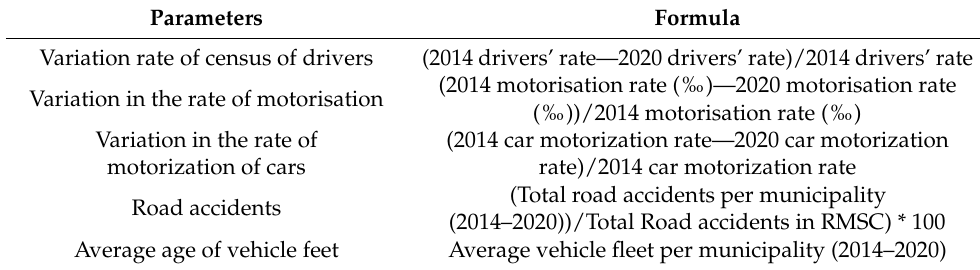
Table 2. Calculation formulas for the parameters